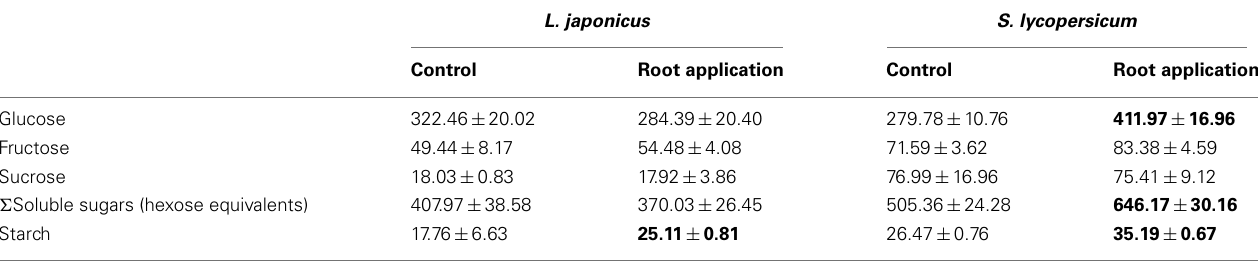
Table 2 | Effect of 5nM lumichrome root application on soluble sugar and starch content of 5-week-old lotus and tomato